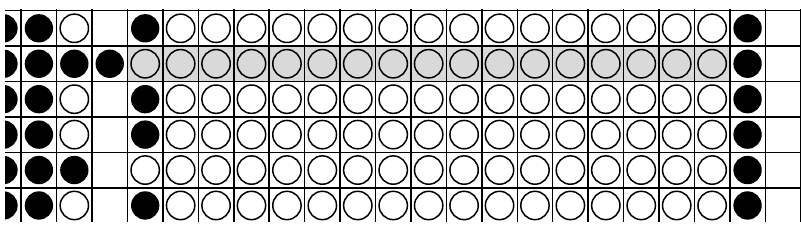
Figure 29. BLACK